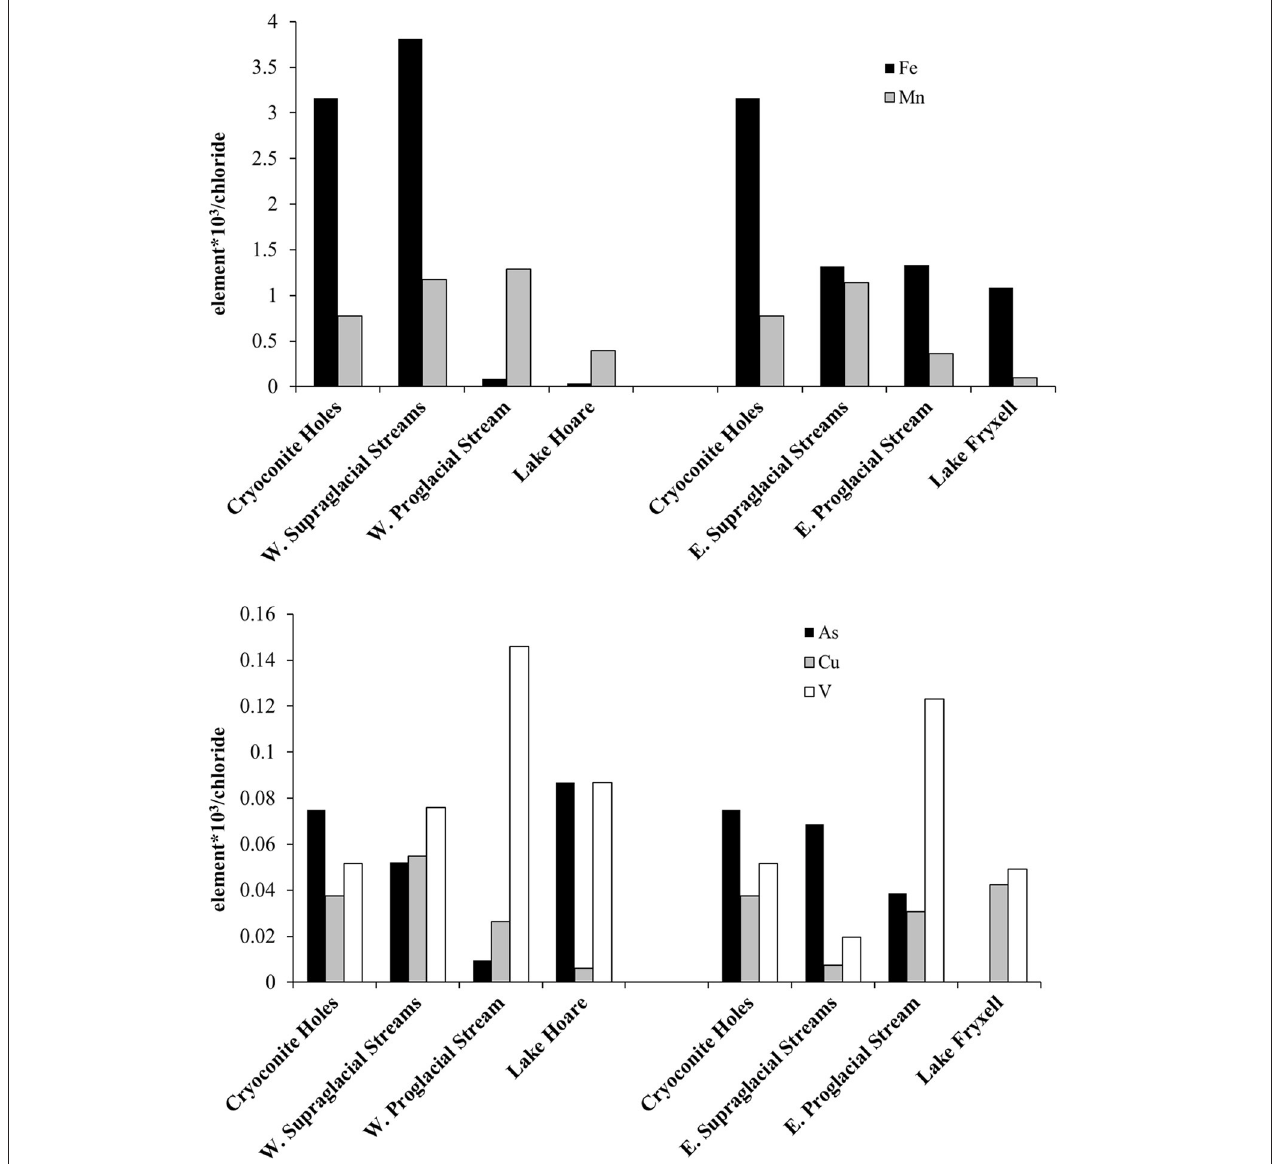
FIGURE 4 | (Top) Median dissolved Fe and Mn concentrations normalized to chloride in cryoconite holes, supraglacial streams, proglacial streams and lakes. Note that western waters are presented on the left and eastern waters are on the right. (Bottom) Median dissolved As, Cu, and V concentrations normalized to chloride in cryoconite holes, supraglacial streams, proglacial streams and